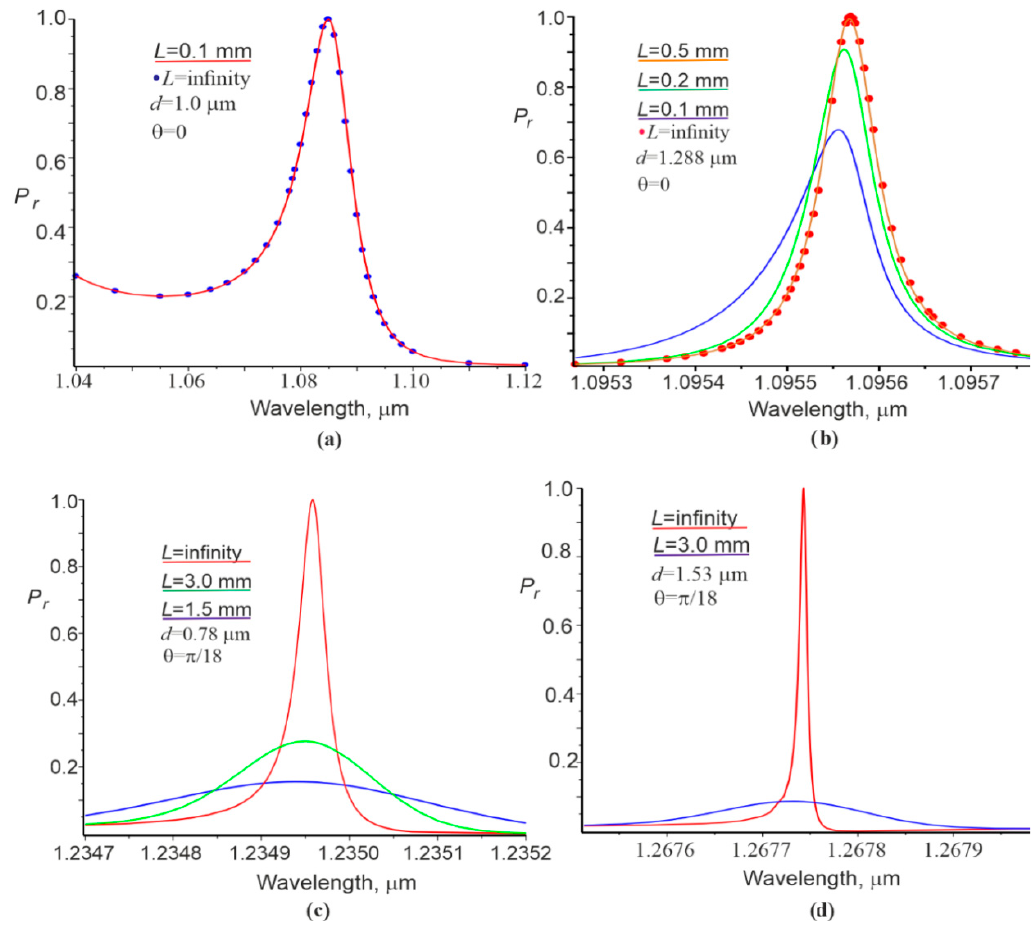
Figure 3. Spectral dependences of the reflection coefficient from the grating for the plane wave ( 𝐿 = infinity ) and the Gaussian beam. The color of the curves corresponds to the color of straight segments under the value of 𝐿 : ( a ) forbidden photon bandgap; ( b – d ) allowed photon bandgap.